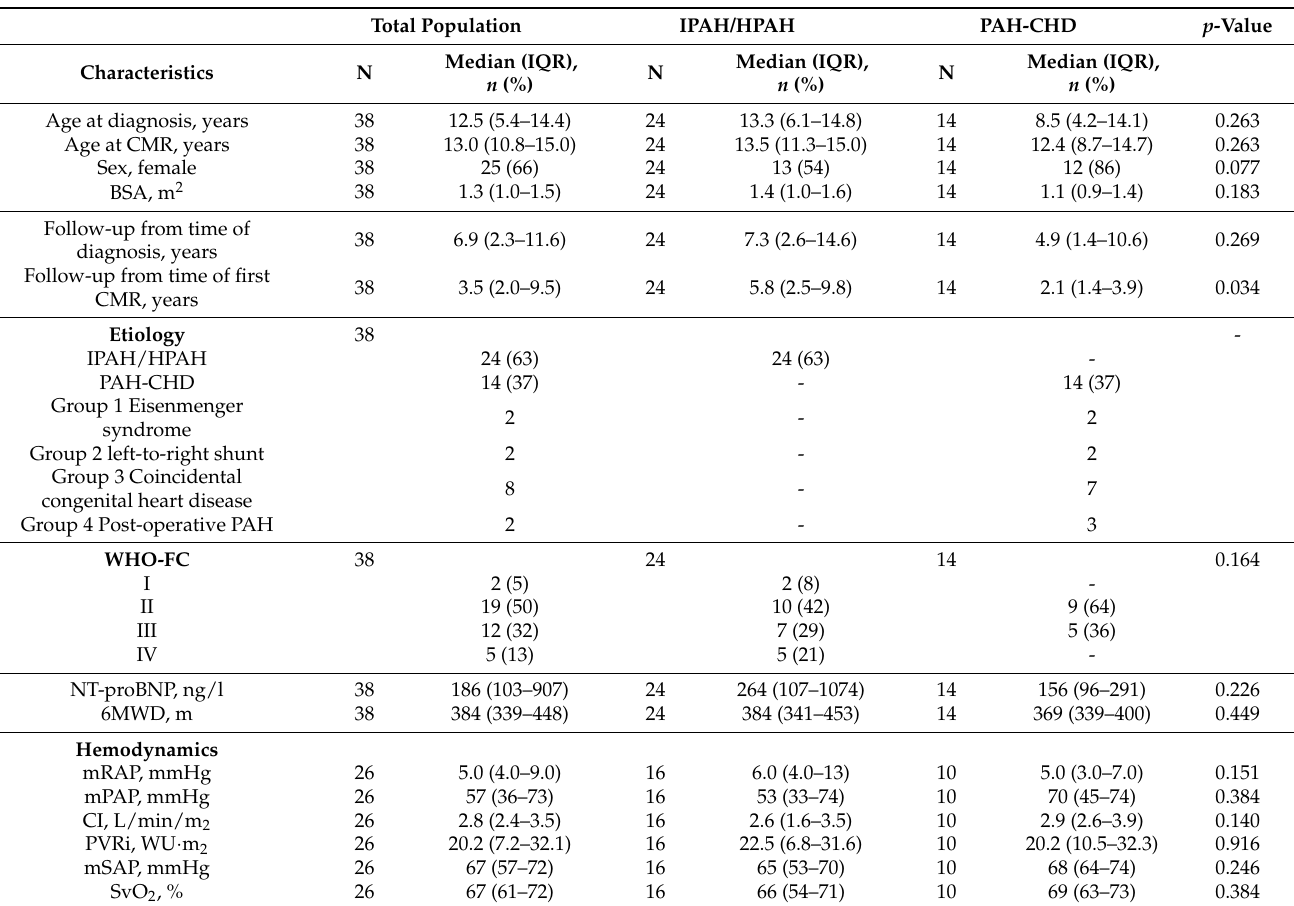
Table 1. Clinical characteristics at time of